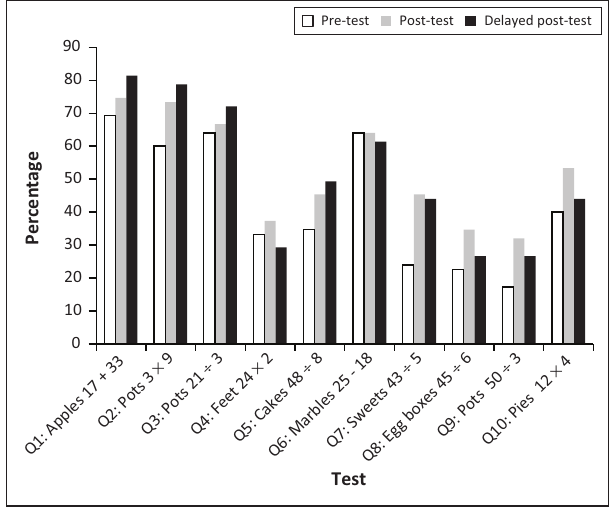
Q, question. FIGURE 8: Grade 3 correct answers (percent), pre-, post- and delayed post-test ( n =